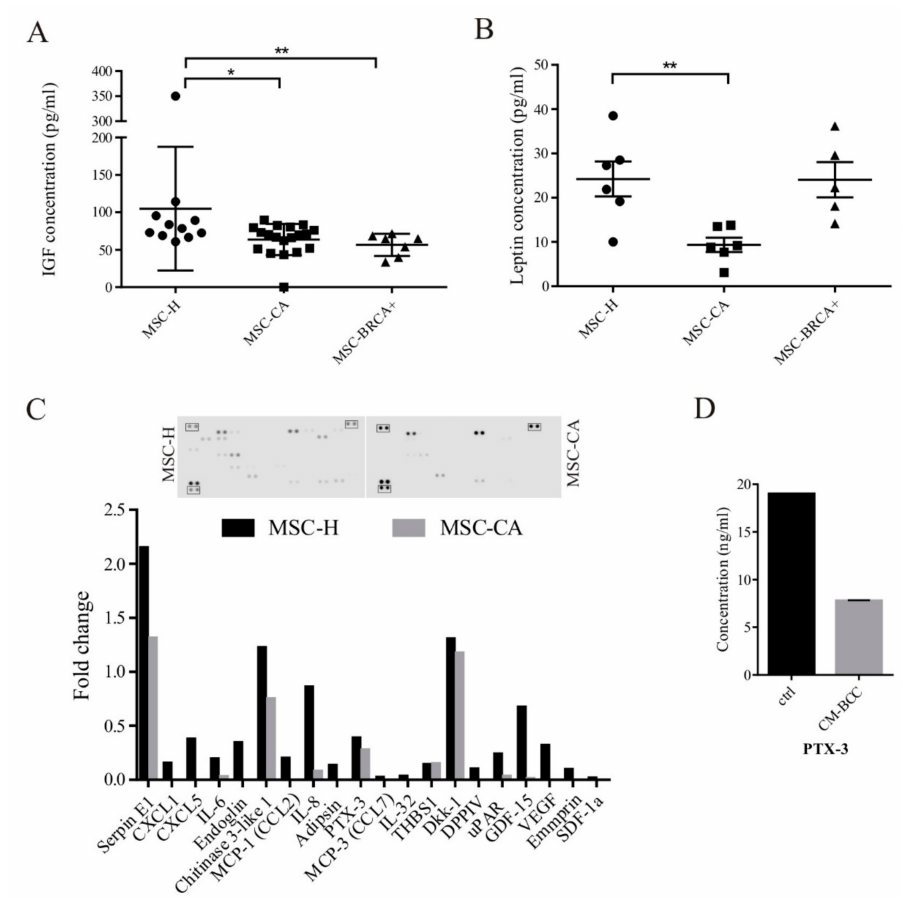
Figure 5. Secretion profile of cancer patient adipose tissue-derived MSCs is halted by tumor cell-secreted factors. ( A ) Decreased expression of IGF1 correlated with decreased IGF1 concentration detected in MSC-CA cell media (* p < 0.05; ** p < 0.01; Mann–Whitney test). ( B ) Leptin concentration in MSC-CA was also lower compared to MSC-H. The IGF1 and leptin concentration was measured by ELISA test in MSC medium after 48 h of culture (* p < 0.05; ** p < 0.01; Mann–Whitney test). ( C ) Cytokine analysis revealed a decreased release of cytokines and chemokines in MSC-CA isolate. The relative change in analyte level between MSC groups was determined by subtraction of each pair of capture antibody from the reference spot signal on the corresponding membrane. ( D ) The PTX3 concentration was decreased in healthy MSCs cultured for 2 weeks in NLR-MDA231 conditioned media. The concentration of PTX3 was measured by ELISA test in MSC medium after 48 h. MSCs used for analysis did not exceed 10th